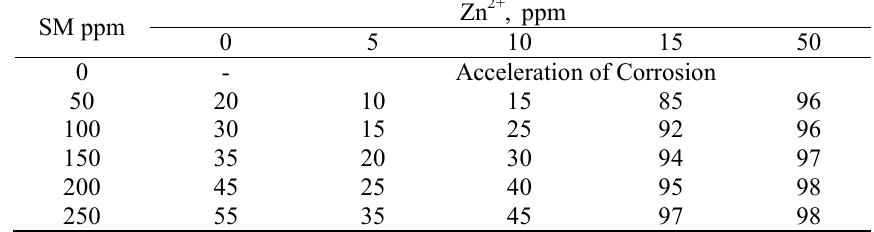
Table 2. Inhibition Efficiency(%) of various SM-Zn 2+ system, when carbon steel is immersed in aqueous solution for one day. Cl - =120 ppm pH=7.